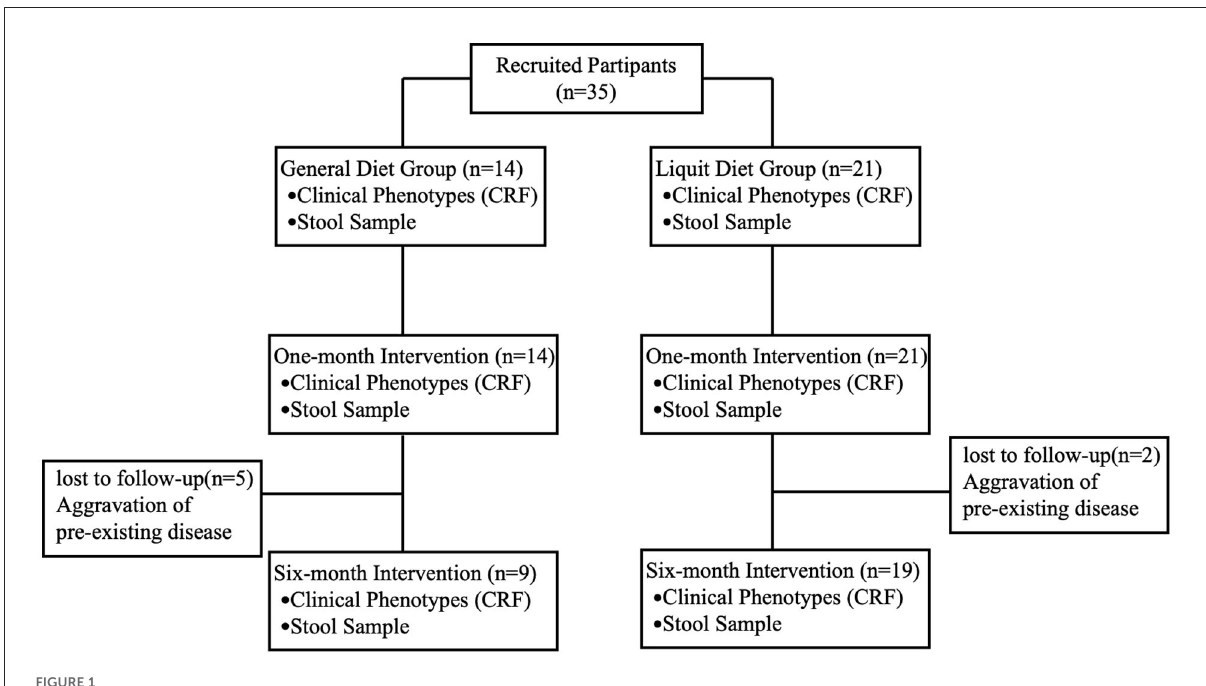
FIGURE1 Flow chart shows the numbers and data collection of participants at each stage.